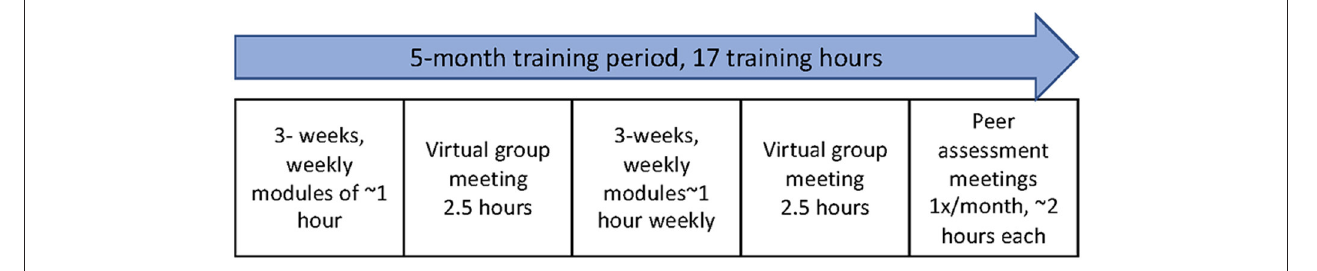
FIGURE 2 | Implementation timeline and dose.